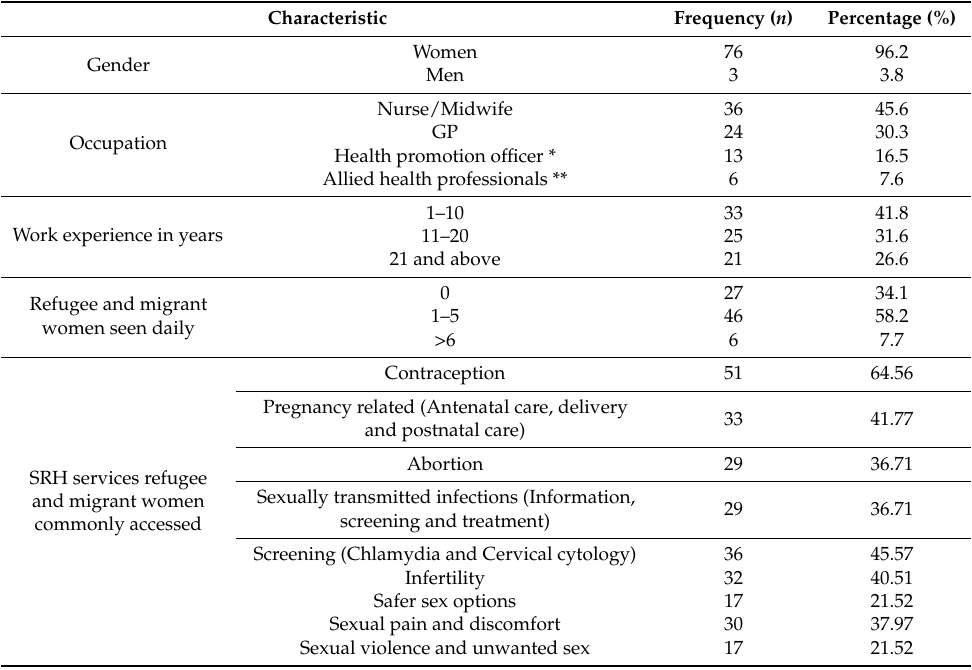
Table 1. Socio-demographic and work experience